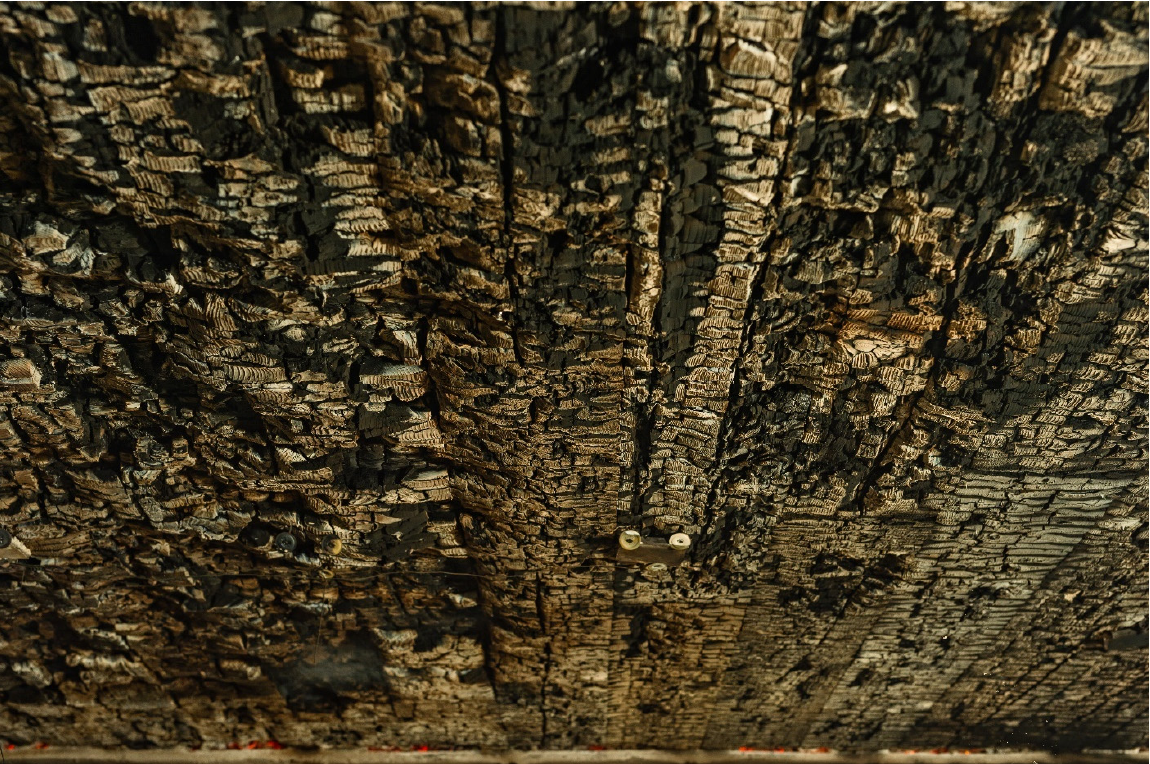
Figure 20. CLT soffit post-experiment in proximity to burner array in Experiment 3.